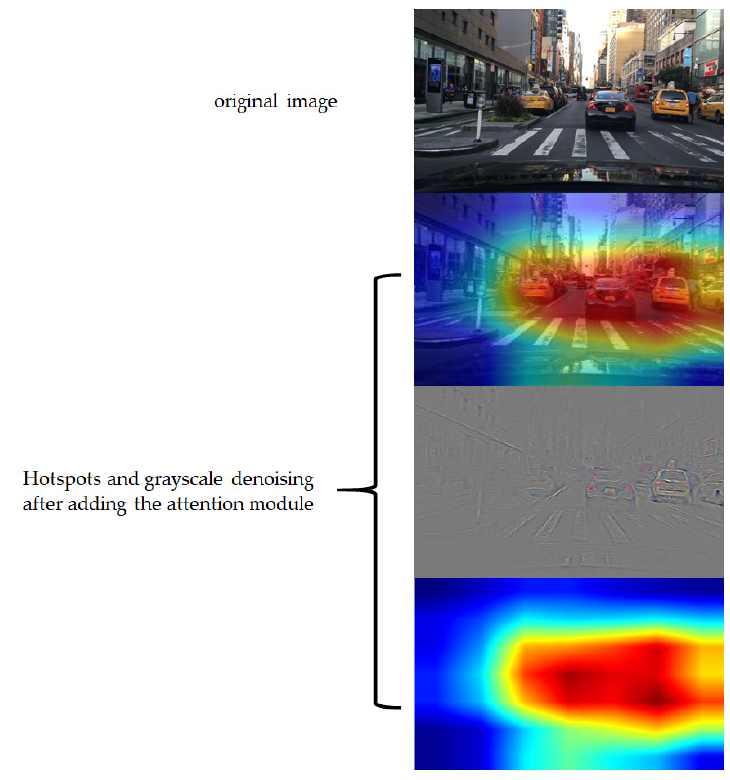
ff ect of attention Figure 6. Effect of attention module. Figure 6. E